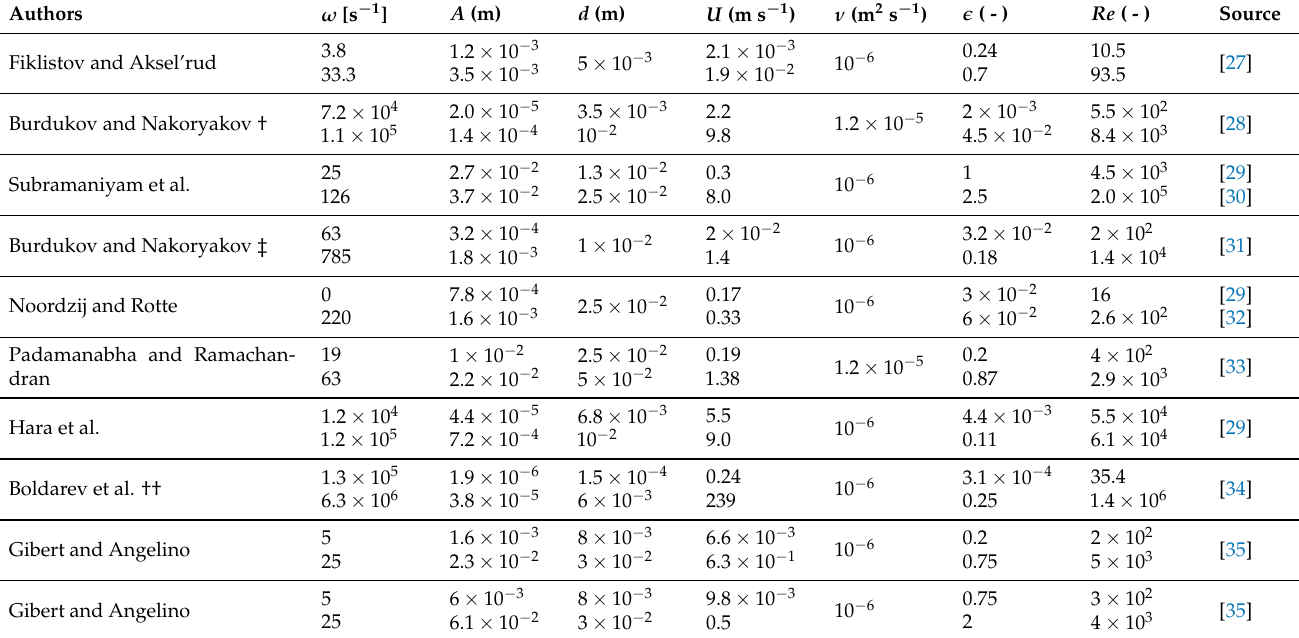
Table A1. A list of investigated works by Al Taweel and Landau [29]. Some of their stated data have been marked (†, ‡, ††) and expanded with information from the original papers.